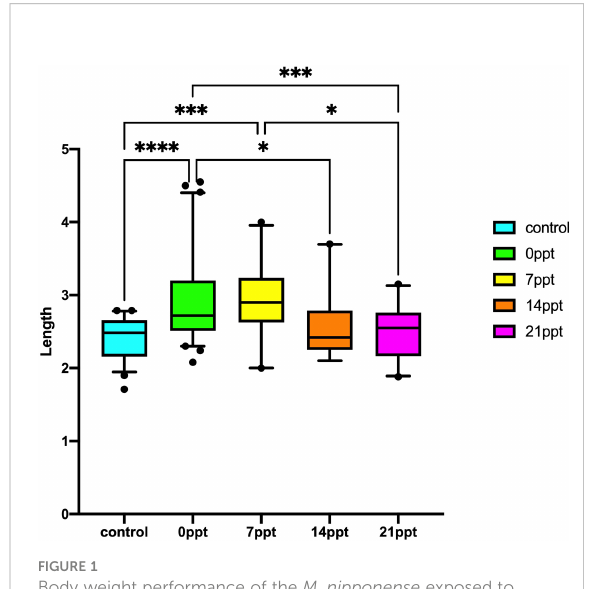
FIGURE 1 Body weight performance of the M. nipponense exposed to different salinity gradients. * indicates the extent of signi fi cant difference (*: p < 0.05, **: p < 0.01, ***: p < 0.001, ****: p < 0.0001).